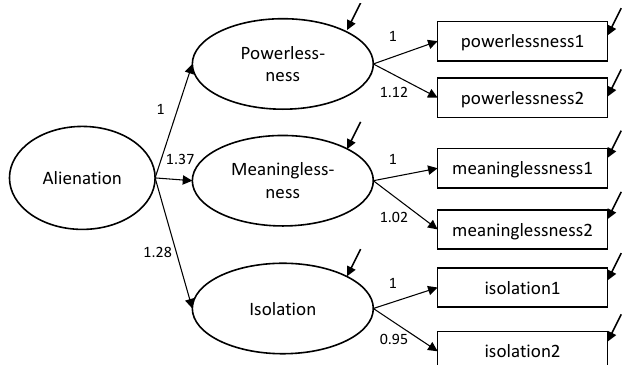
Figure 1 The second-order factor measurement model of alienation. The num- bers are invariant unstandardized factor loadings as estimated in a second-order metric invariance model (corresponding to Model 3 in Table